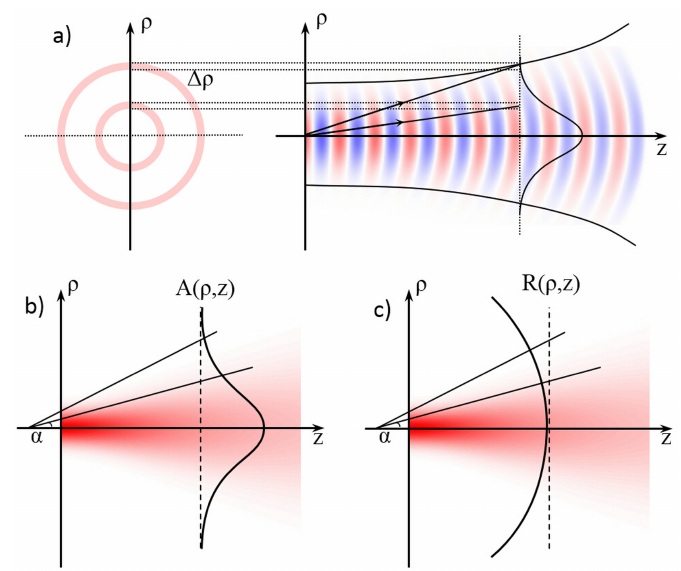
Figure 6. Scheme of the optical field determination from a Gaussian laser beam with the paraxial ray optics approach. ( a ) The power carried by each ray, is calculated as the integral of the beam intensity, as a function of the radial coordinate within the area of the annulus associated to the ray; ( b ) The amplitude A ( ρ , z ) and the ( c ) curvature radius R ( ρ , z ) along the axis z are calculated, which will be exploited respectively for the evaluation of the power and the propagation direction of each ray.